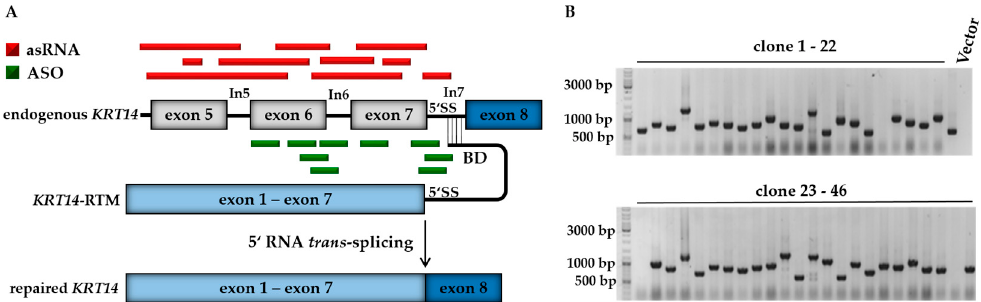
Figure 1. The combined application of antisense strategies. ( A ) The RTM, the main component of the SMaRT system, carries the wild-type coding sequence of KRT14 spanning from exon 1 to exon 7, splicing elements for efficient splicing and a binding domain specific for intron 7 of KRT14 . Antisense molecules were randomly (red) and rationally (green) generated in order to block competitive cis -splicing elements within the KRT14 target region, thereby facilitating the trans -splicing-induced RNA repair of our pre-selected RTM; ( B ) for asRNA library generation the PCR-amplified KRT14 target region (1142 bp), spanning from exon 5 to intron 7, was fragmented by sonication and the resulting fragments were randomly cloned into a pcDNA 4.0 expression plasmid. Colony PCR and sequence analysis of individual bacterial clones revealed the presence of various target sequences in sense and antisense orientation. Vector: pcDNA 4.0 expression vector without KRT14 sequence; RTM, RNA trans -splicing molecule; 5 ′ SS, 5 ′ splice site.